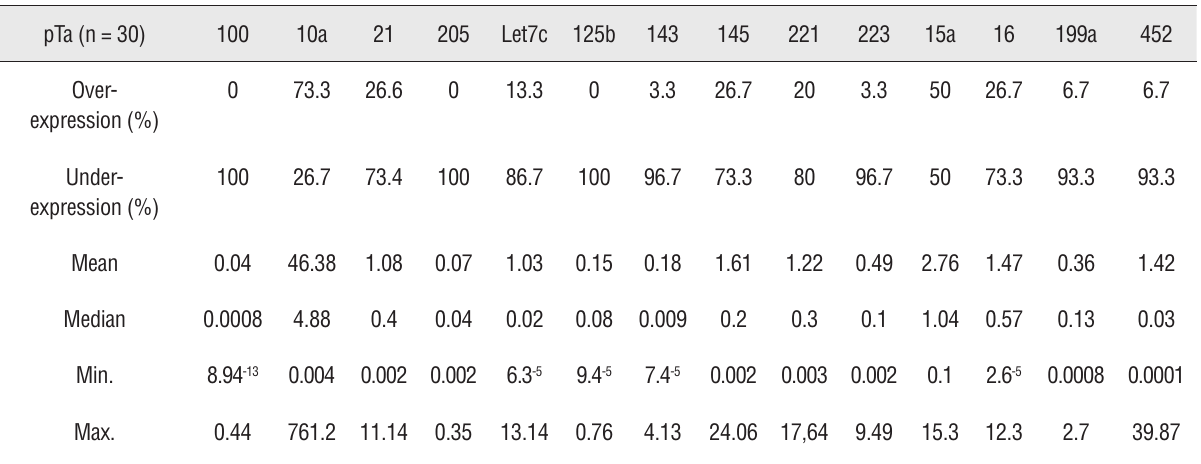
Table 1 - Expression profile of 14 miRNAs studied in 30 low-grade non-invasive pTa tumors. Means and medians of expression are also presented compared with normal controls.